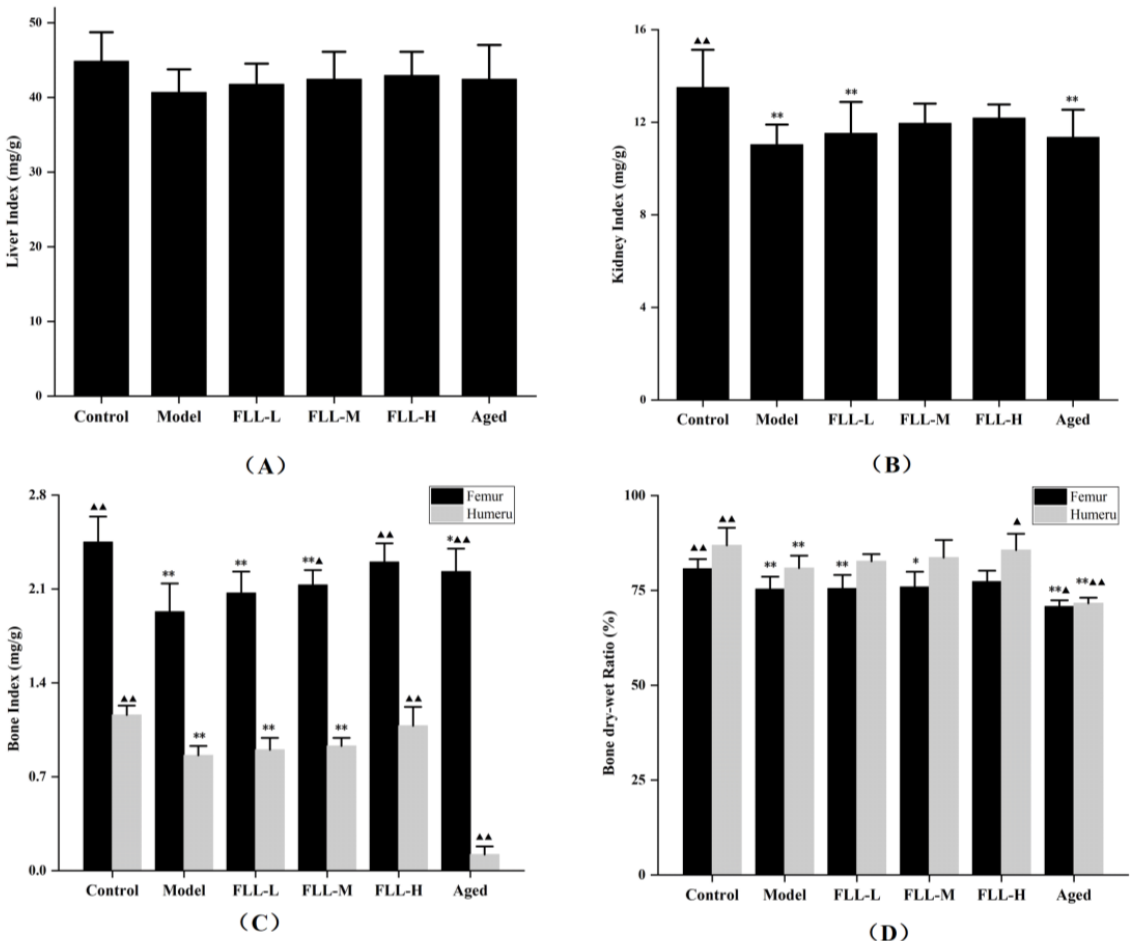
Figure 2. Effects of FLL on liver index ( A ), kidney index ( B ), bone index in femur and humerus ( C ), and bone dry–wet ratio in femur and humerus ( D ) in mice of each group. Organ index (mg/g) = organ weight (mg)/body weight (g). Bone index (mg/g) = bone wet weight/body weight × 1000. Bone dry–wet ratio (%) = bone dry weight/bone wet weight × 100%. Compared with the control group, * p < 0.05 and ** p < 0.01. Compared with the model group, ▲ p < 0.05 and ▲▲ p < 0.01.